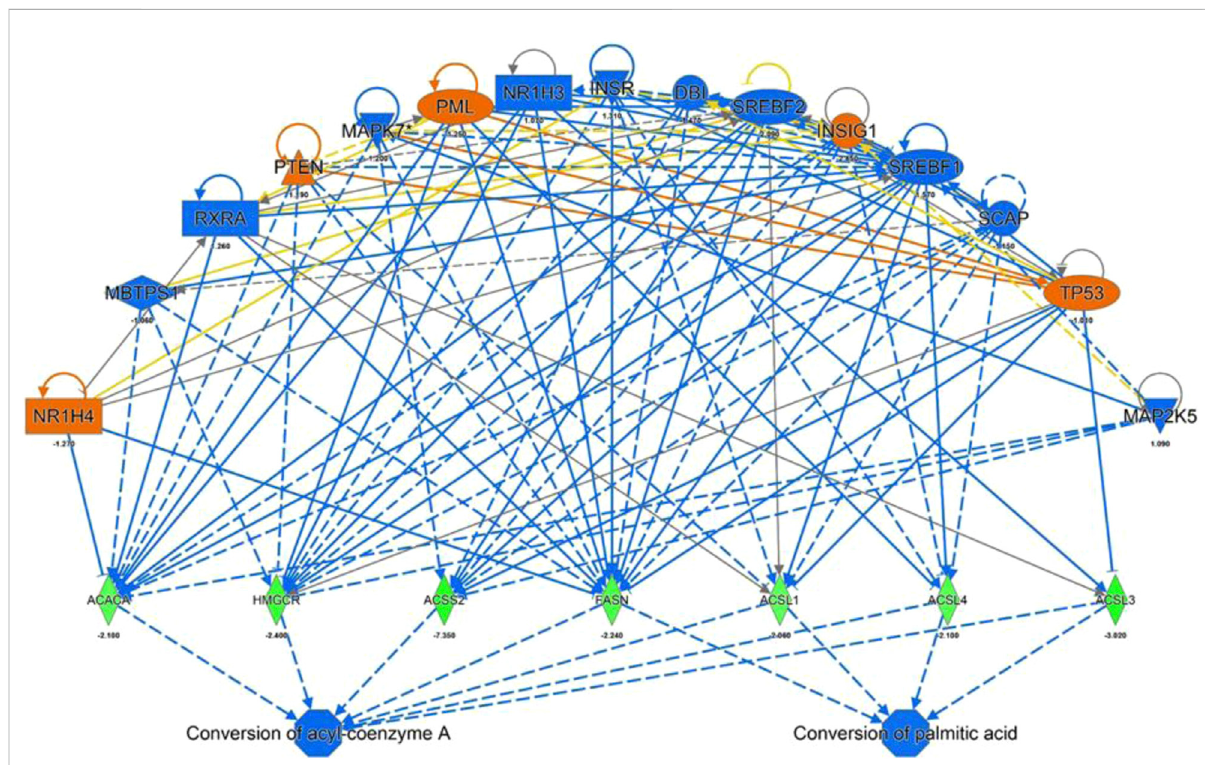
FIGURE 4 IPAUpstreamRegulatorsAnalysisforidenti fi cationofupstreamregulatorsthatmayberesponsibleforchangesingeneexpressionobservedfor ACACA, HMGCR, ACSS2, FASN, ACSL 1,3 and 4 (predicted activation (orange) predicted inhibition (blue) of the regulators leads to a decreased expression